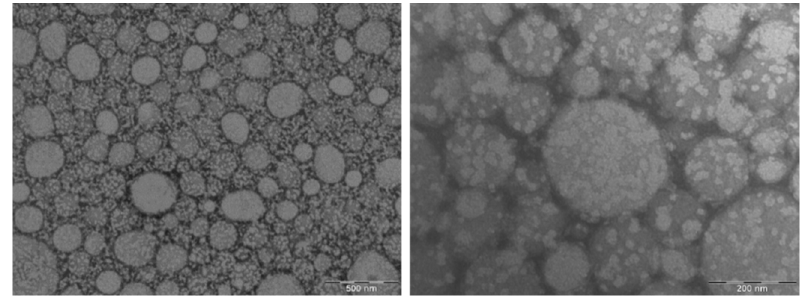
Figure 6. Transmission electron microscopic images of DXI-loaded nanostructured lipid carriers (DXI-NLC) with 500 nm and 200 nm scale.